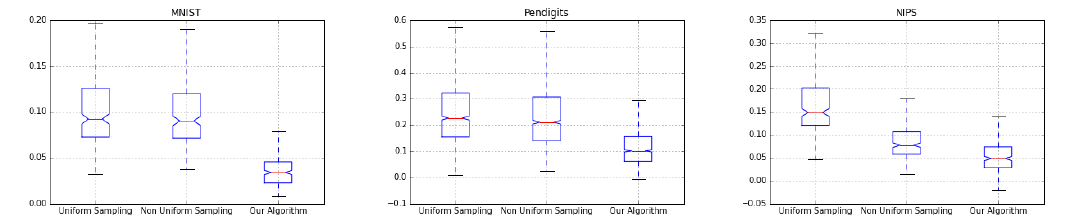
Figure 6. Error (y-axis) box-plots for real-data sets, streaming computation model.